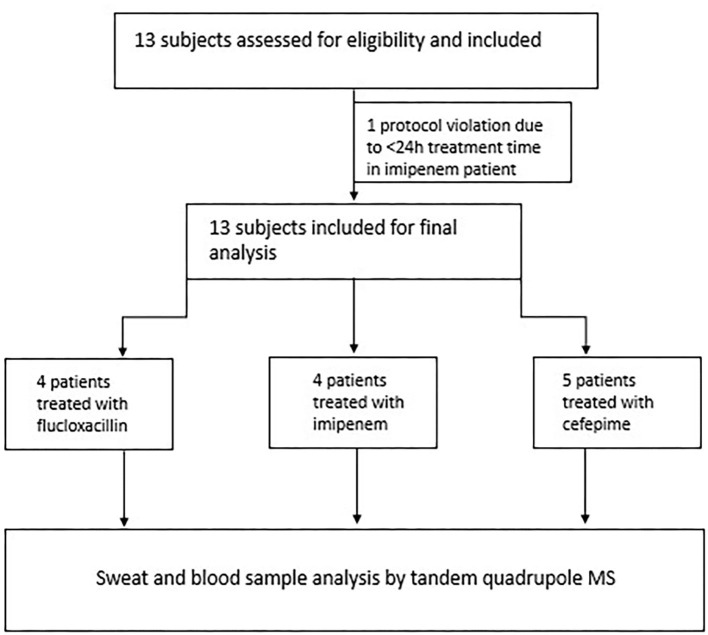
Patient flowchart: inclusion and exclusion of study patients.